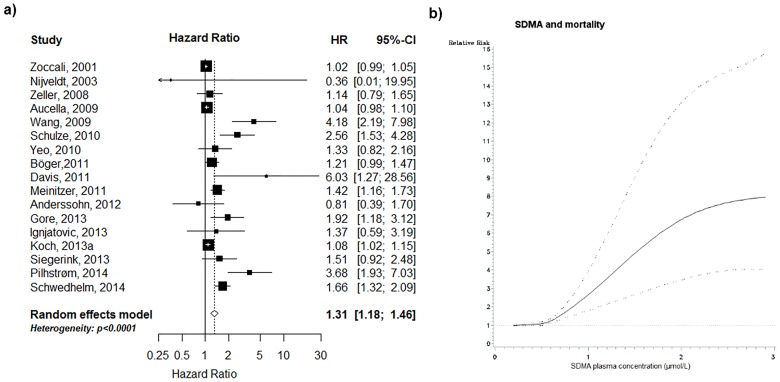
SDMA and all-cause mortality: a) high versus low analysis, and b) non-linear dose-response analysis (based on 4 studies, p for non-linearity = 0.010).Black square: point estimate for individual study; horizontal line: 95% CI for observed effect in each study; diamond: pooled estimate and 95% CI for meta-analysis. Random-effects estimate (DerSimonian and Laird method).